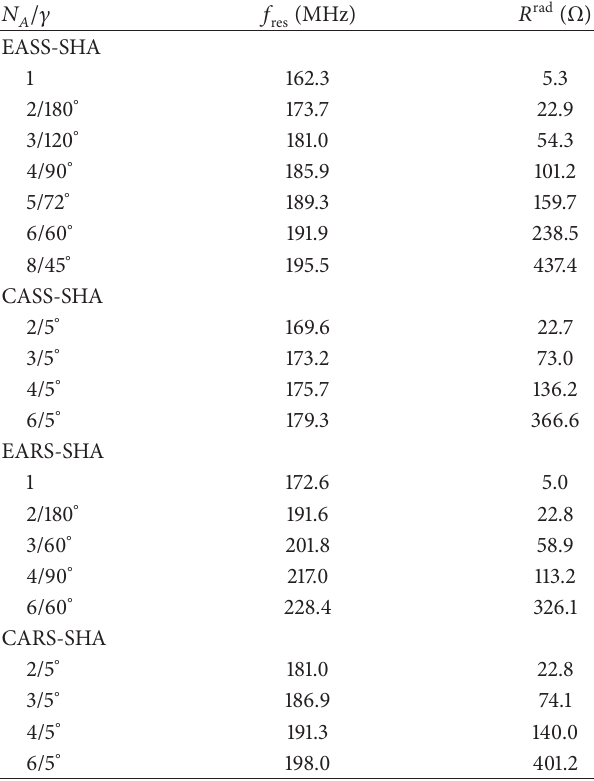
and in antiresonance at 306 MHz. The percentage of the particular mode in the total power ( |𝐸 𝜑 /𝐸 depicted in the bottom in Figure 3 shows that the TM mode is dominant at low frequencies, whereas the TE mode starts to dominate over TM after 273 MHz, just before the antiresonance appears.